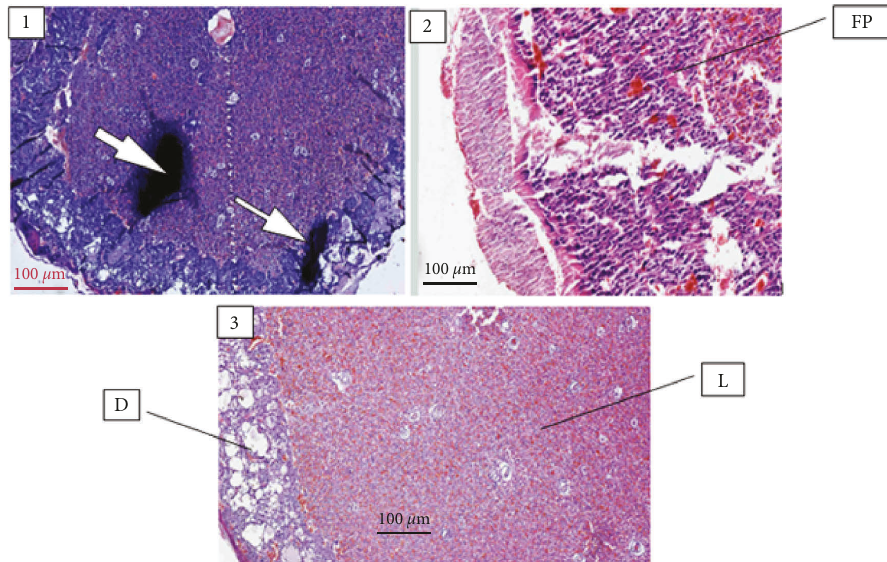
Figure 3: Photo micrograph depicting the following: (1) a calcified placental tissue (arrow) from rats treated with 1000mg/kg of Embelia schimperi , (2) fibroprulent tissue (FP) from rats treated with 500mg/kg, and (3) normal histology of placenta from the control rats; decidual layer (D), labyrinthine zone